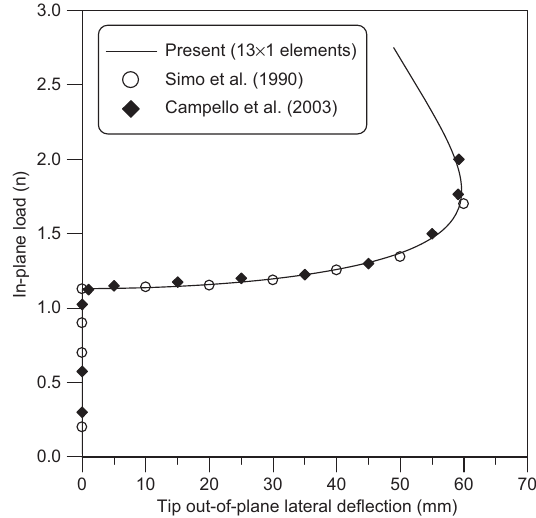
Figure 5 Out-of-plane defl ection at the free end of the L-shaped